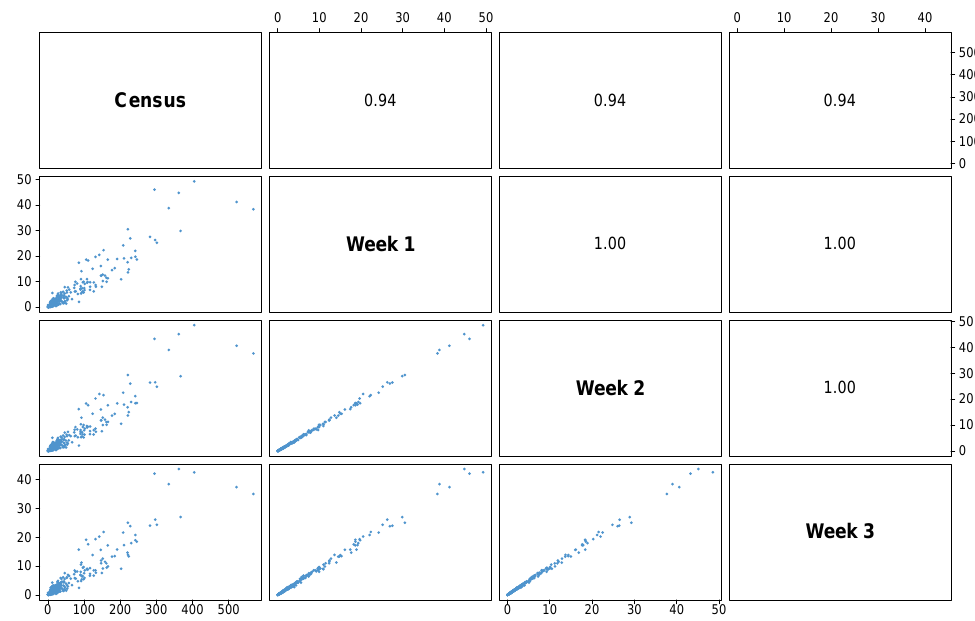
Figure A2. Comparison between census and XDR data. Each scatter plot and its associated Pearson correlation coefficient represents a comparison between the number of inhabitants (expressed in thousands of individuals) in the census and the number of inhabitants (expressed in thousands of individuals) estimated with XDR data (i.e., reliable users) during the three weeks of observation. Each point represents one municipality of Chile.